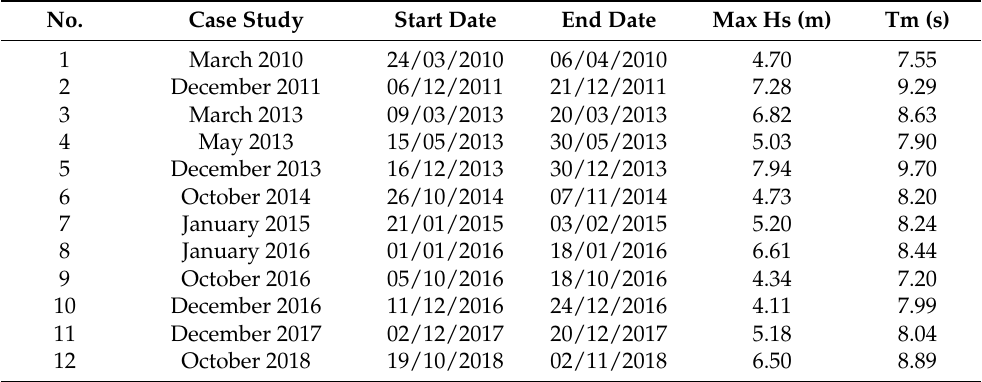
Table 4. Time period of the case studies considered for calibration analysis. In the last two columns we also report the observed maximum significant wave height and corresponding mean period. No. Case Study Start Date End Date Max Hs (m) Tm